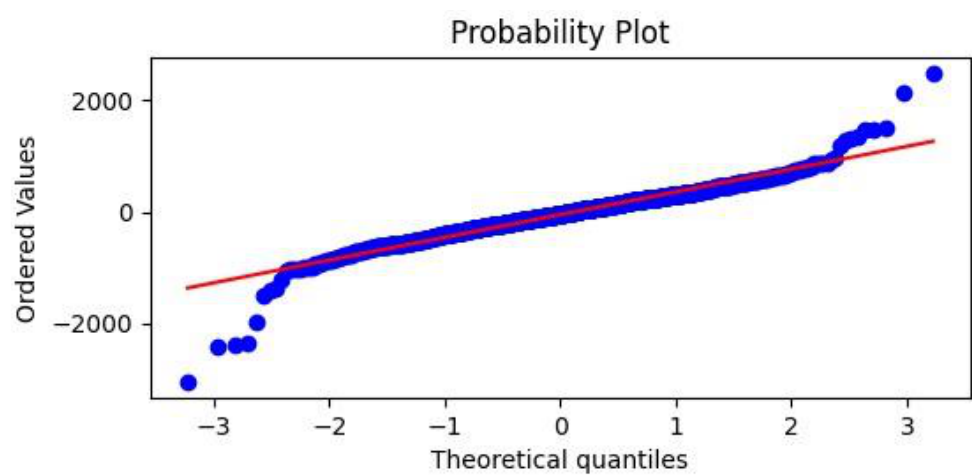
Figure 13. A Q–Q (quantile–quantile) plot resulting from the validation process of Figure 13. A Q – Q (quantile – quantile) plot resulting from the validation process of V-MLP-12